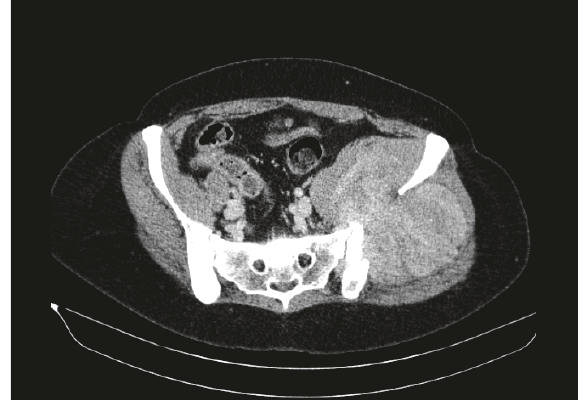
Figure 3: Contrast-enhanced CT. Axial view. There is a heteroge- neous enhancing mass destroying the left iliac bone and expanding both in and out of the pelvic cavity. The iliac vessels have deviated towards the right. No evident infiltration of pelvic structures was